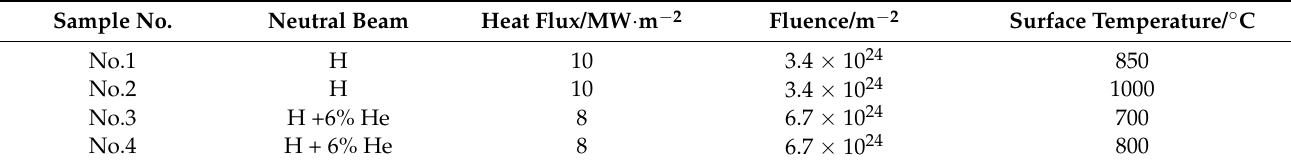
Table 1. Irradiation parameters of CVD-W